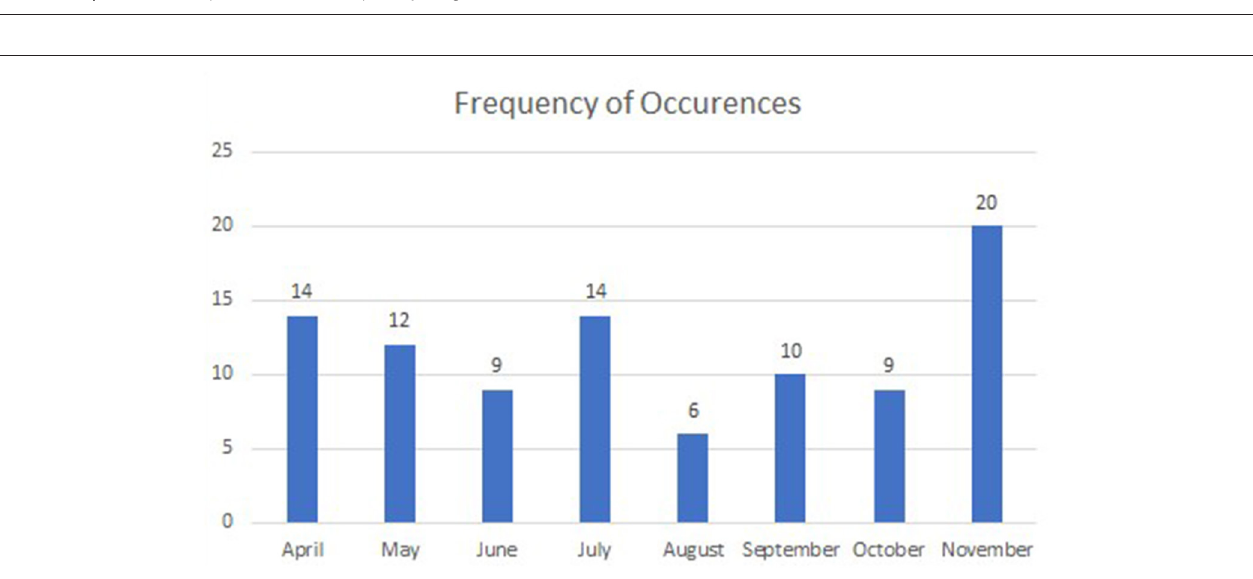
FIGURE 3 | Distribution of patients, based on specialty sought.